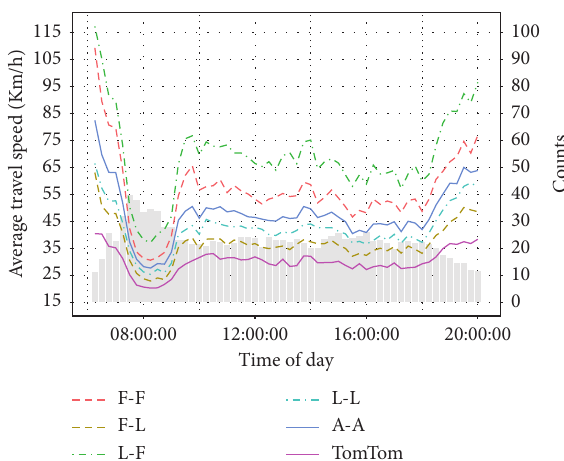
Figure 9: An example of calibrating the average BTspeed. A-A BT speed represents the average speed deriving by A-A matching method.